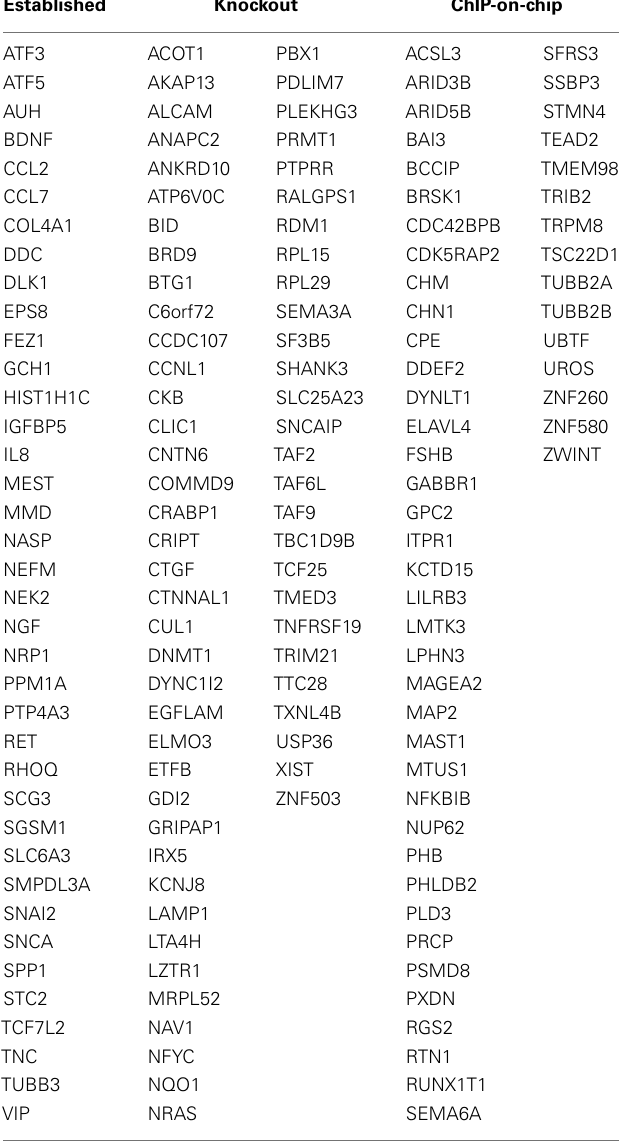
Table 1 | Known and putative NURR1 target genes showing NURR1-dependent differential expression in clonal